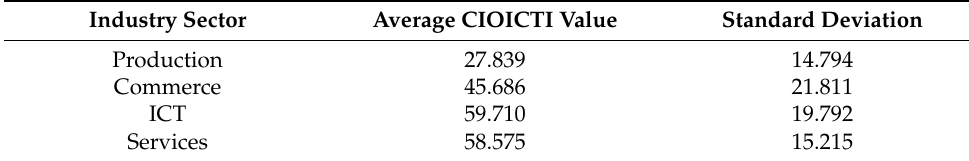
Table 9. Average values of the CIOICTI with respect to the industry sector.